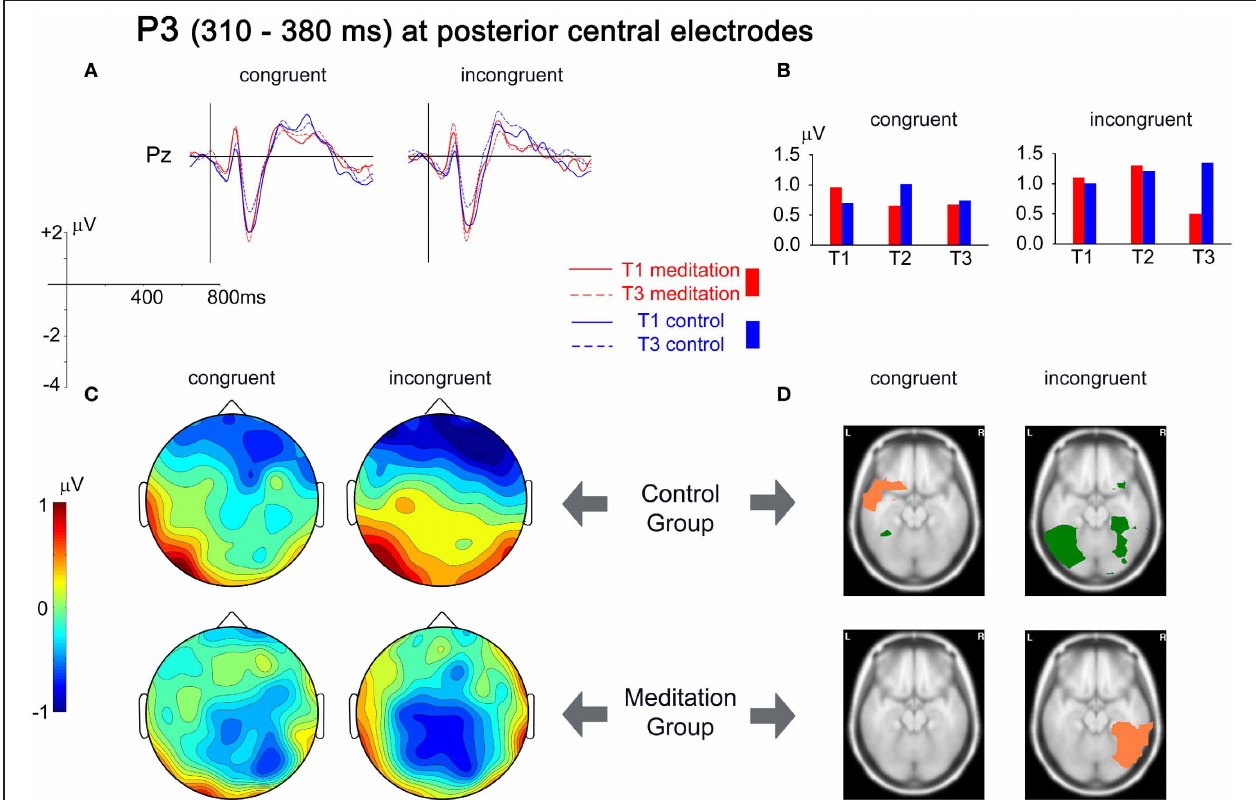
FIGURE 5 | Analysis of the P3 time window, from 310 to 380ms. (A) Grand mean averages for meditation and control group for T1 and T3 for electrode Pz. (B) Mean P3 amplitudes from T1 to T3 averaged for the same electrode. (C) Spherical spline interpolated scalp topographies of the difference between T1 and T3 (T3–T1) for meditation and control group, separated for congruent and incongruent stimuli. Positive values indicate an